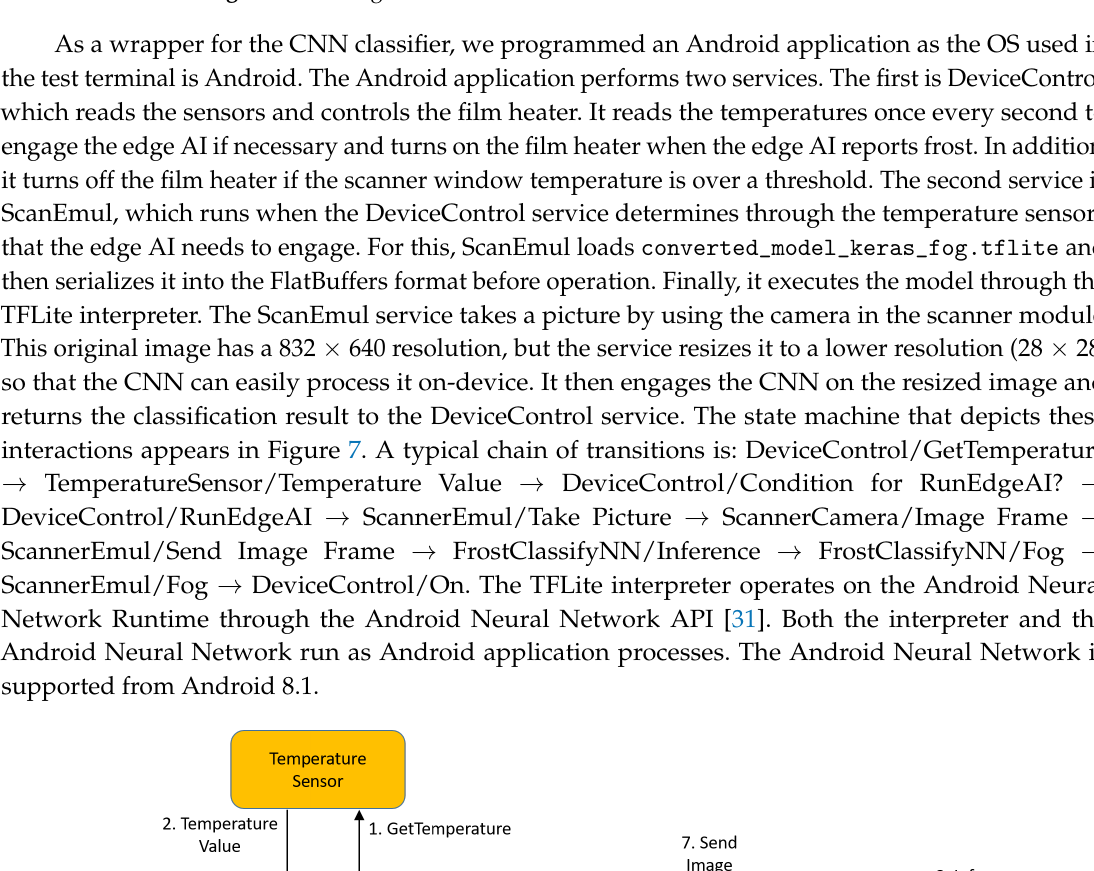
Figure 6. Loading the trained model to our industrial mobile terminal.